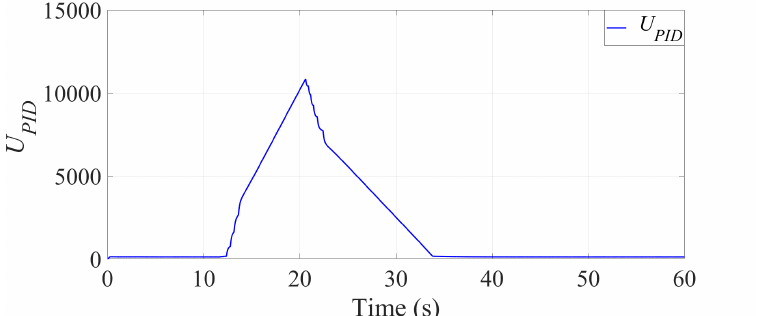
Figure 21. Control input produced by the classical PID controller to manipulate the duty cycle of a PWM signal.